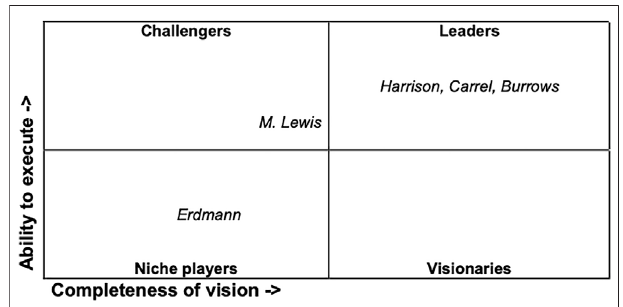
FIGURE 3 | Magic Quadrant Tissue Culture, state around